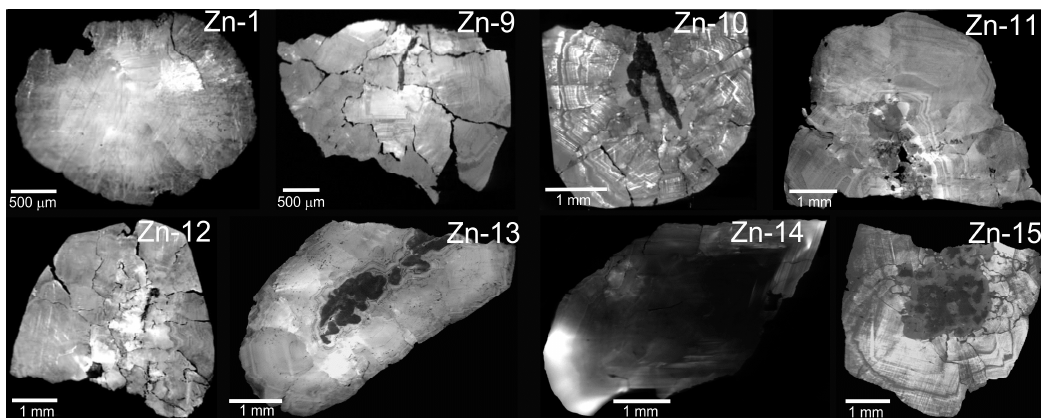
Figure 4. Cathodoluminescence images of polished plates from diamond showing zoning structures, and irregularly shaped polycrystalline cores with dark luminescence.